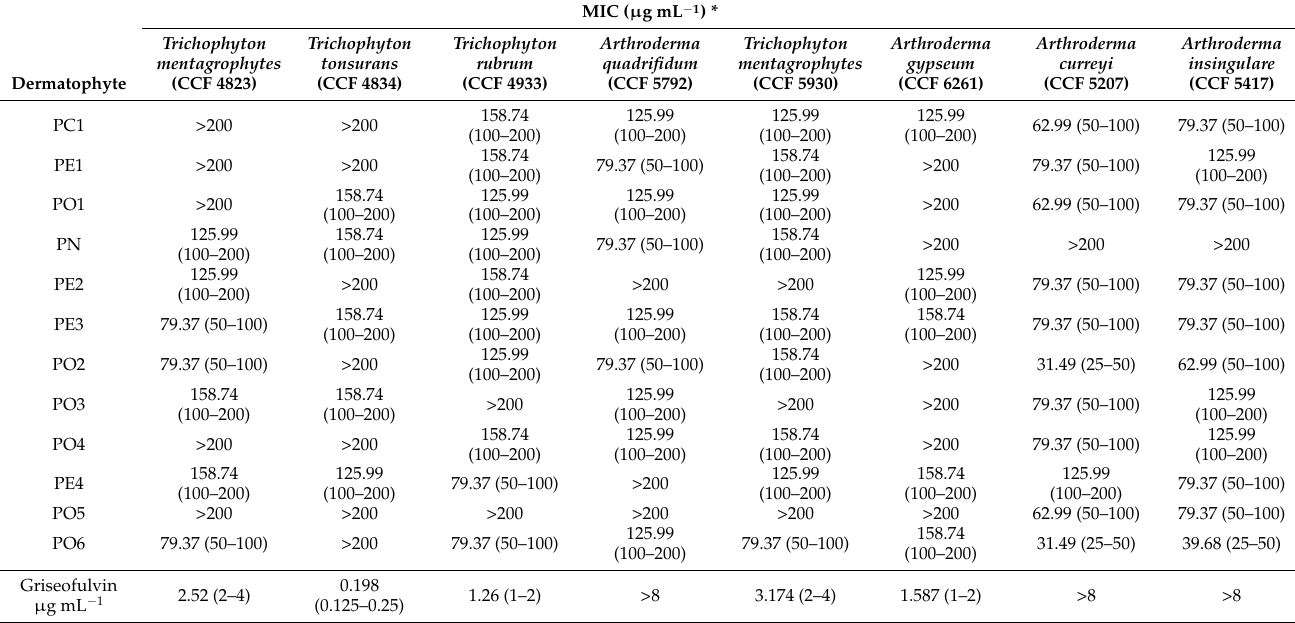
Table 10. Minimal inhibitory concentrations (MICs) of Pleurotus mycelia (S1) extracts against der- matophyte